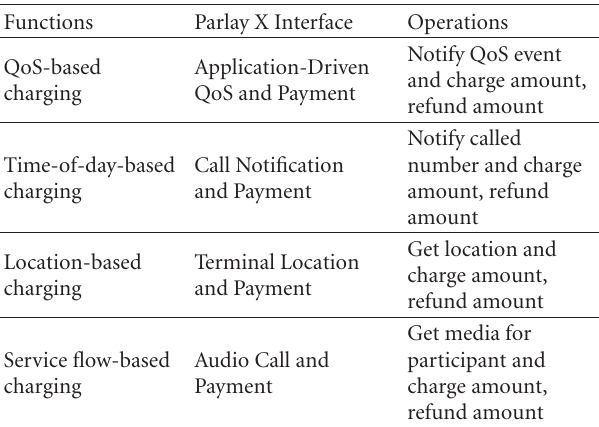
Table 2: Advanced charging